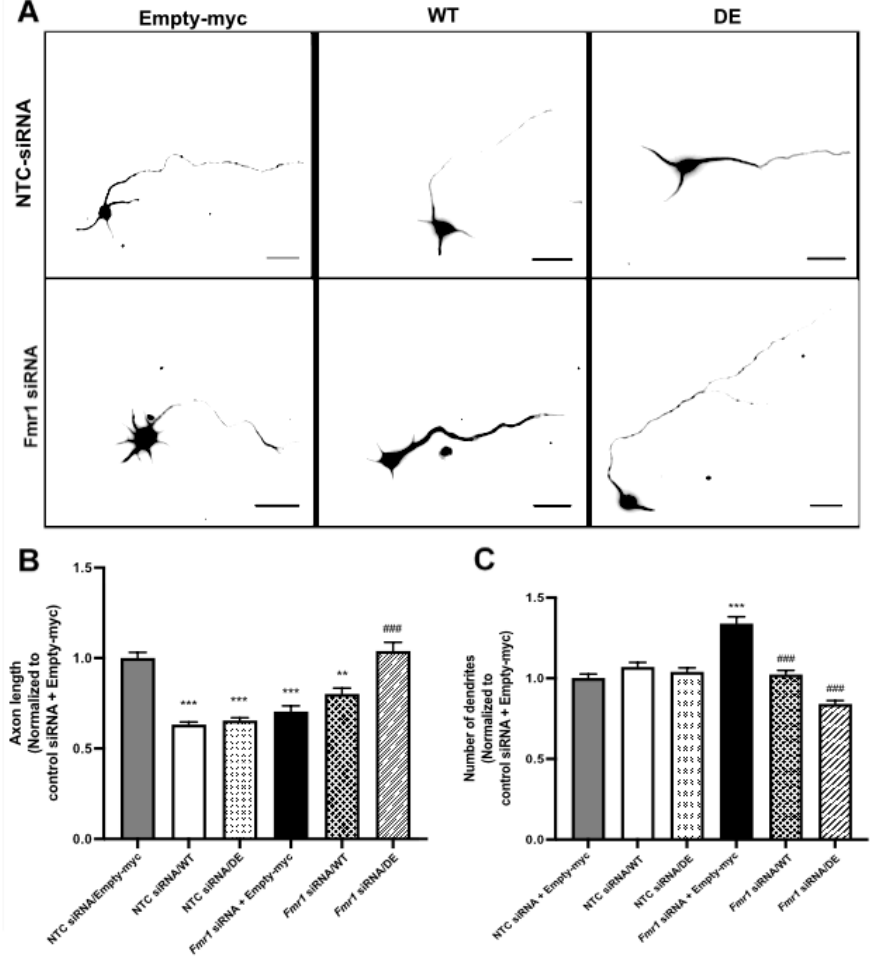
Figure 3. The RACK1 up-regulation rescues the defect induced by Fmr1 siRNA in 2DIV neurons. Overexpression of RACK1 can rescue phenotypic defects underlying Fragile X syndrome. A) E17 mouse cortical neurons were transfected as in Figure 2. Using immunofluorescence (IF), neurons were stained for beta-tubulin and myc, and only myc-stained neurons were analyzed. Fmr1 knock- down results in a reduction in axon length, which is normalized by overexpression of RACK1 DE-his- myc (DE in figure). Fmr1 knockdown also increases the number of dendrites which are normalized by overexpression of RACK1 DE-his-myc . Scale bars, 25 μm. Brightness and contrast were adjusted to optimize the visibility of axons. B) Fmr1 knockdown results in significantly shorter axons. Overex- pression of RACK1 DE-his-myc normalizes this phenotype. Data normalized to non-targeting control (NTC) siRNA/empty-myc. One-way ANOVA with Tukey’s Post Hoc test, n = 90 for each experi- mental group. *** p < 0.0001, significant as compared to NTC siRNA/Empty-myc, ** p < 0.001, signif- icant as compared to NTC siRNA/Empty-myc, ### p < 0.0001, significant as compared to Fmr1 siRNA/Empty-myc. Fmr1 siRNA + Empty-myc not significantly different from Fmr1